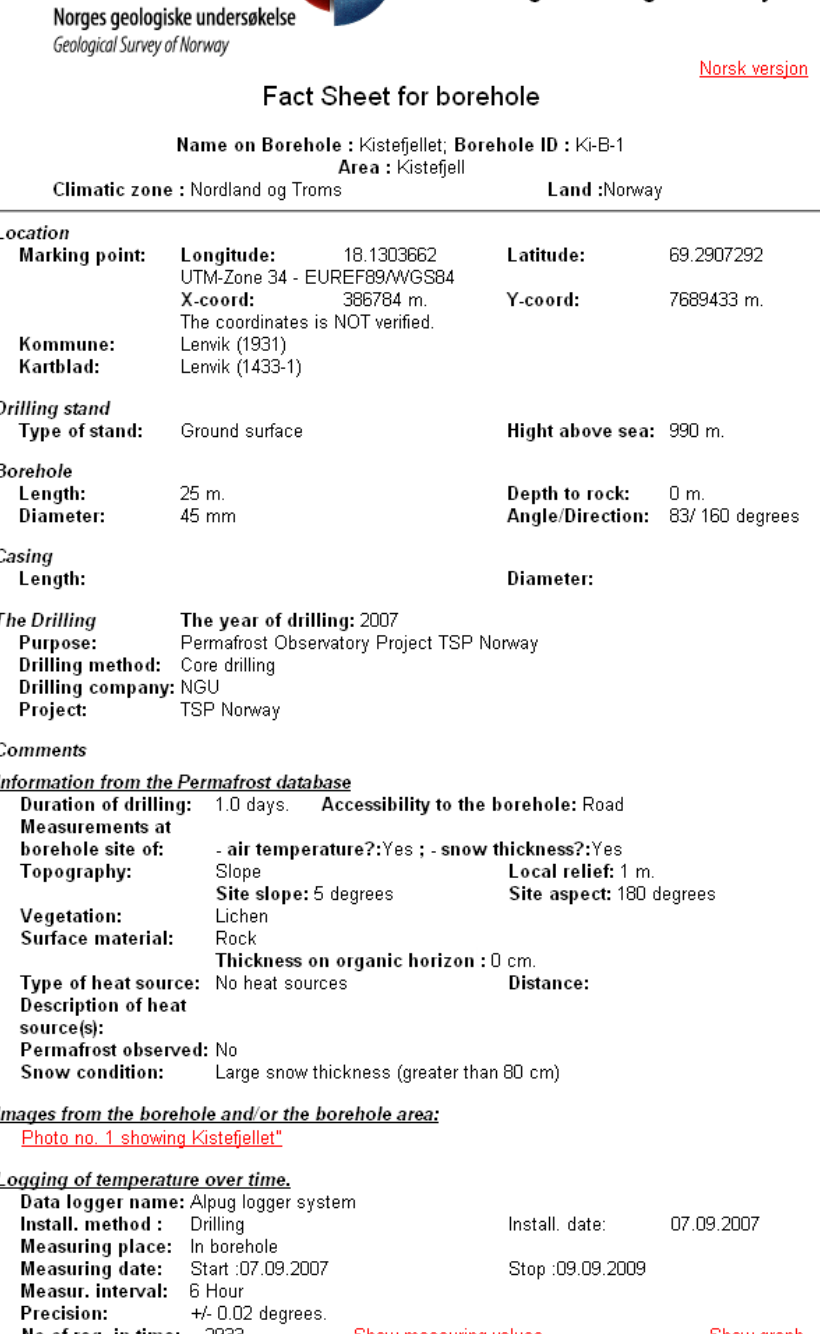
Figure 8. Example of a borehole fact sheet for the Kistefjellet (KI-B-1) borehole.